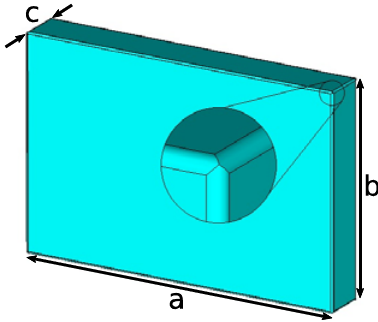
Figure 1. Blood bag parallelepiped rounded wedges.